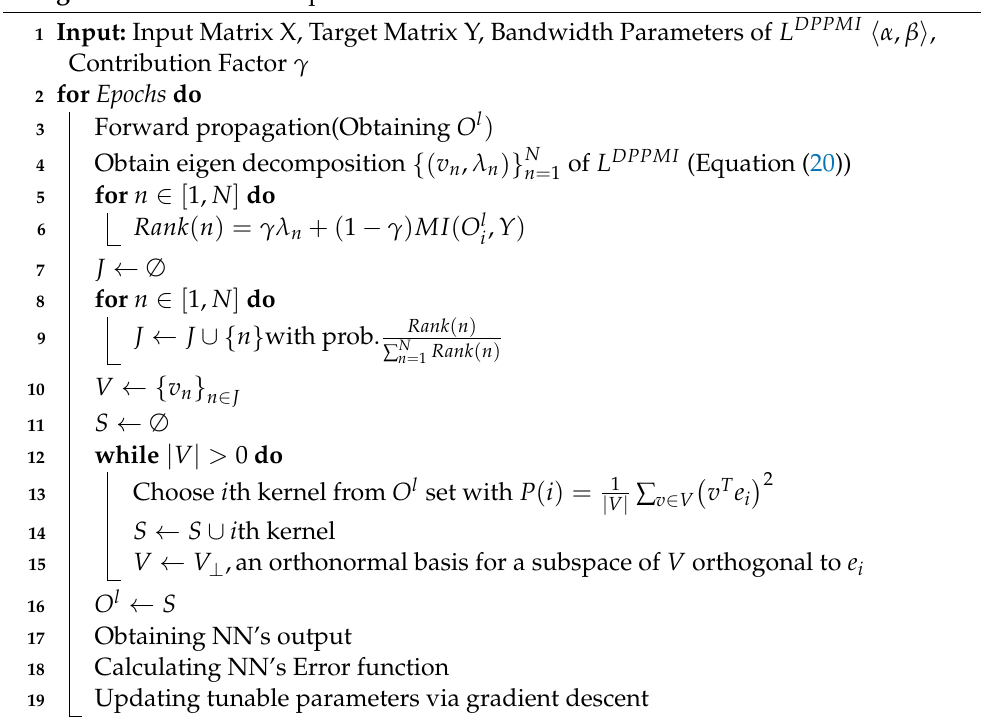
Algorithm 3: DPPMI